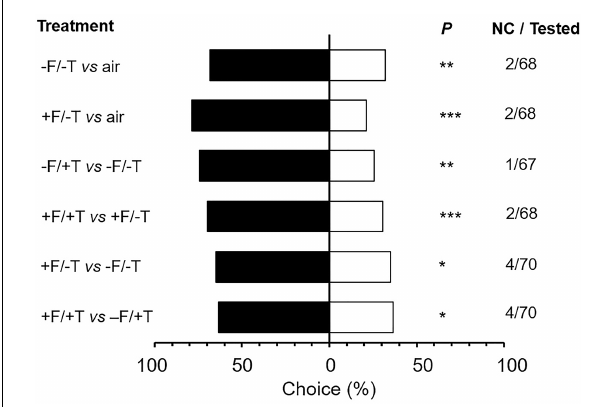
FIGURE 8 | Responses of the generalist predator Macrolophus pygmaeus to volatiles emitted by tomato plants colonized by the endophyte Fusarium solani strain K (+F) and/or infested with spider mites ( T. urticae , +T) or clean air (air). One week after seed sowing plants were either inoculated with the endophyte (+F) or not (–F). Subsequently, plants were either infested with 200–300 spider mite females (+T) or not (–T) when 4–5 weeks-old for a period of 2 days. Shown are the percentages of predator females that moved toward the volatile sources in the corresponding choice situations indicated on the left (under ‘Treatment’) in a vertical Y-tube olfactometer. ‘NC/Tested’ indicates the number of individuals that did not make a choice over the total number of tested individuals (67–70 individuals depending on the treatment combination). Significant differences are indicated by asterisks after a χ 2 test: ∗ P < 0.05, ∗∗ P < 0.01, ∗∗∗ P <